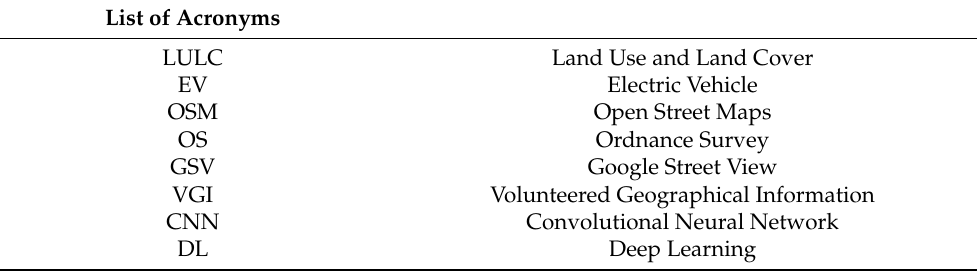
Table 1. A list of acronyms and abbreviations used throughout the